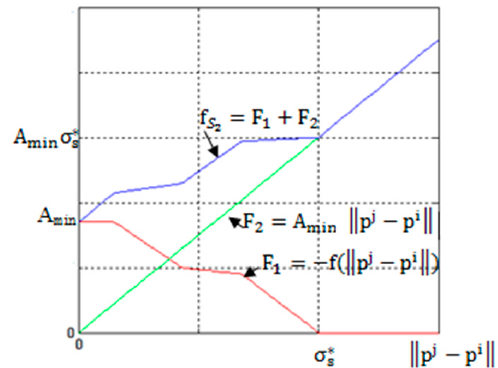
. Figure 3. The graph of total f S 2 (cid:3118)